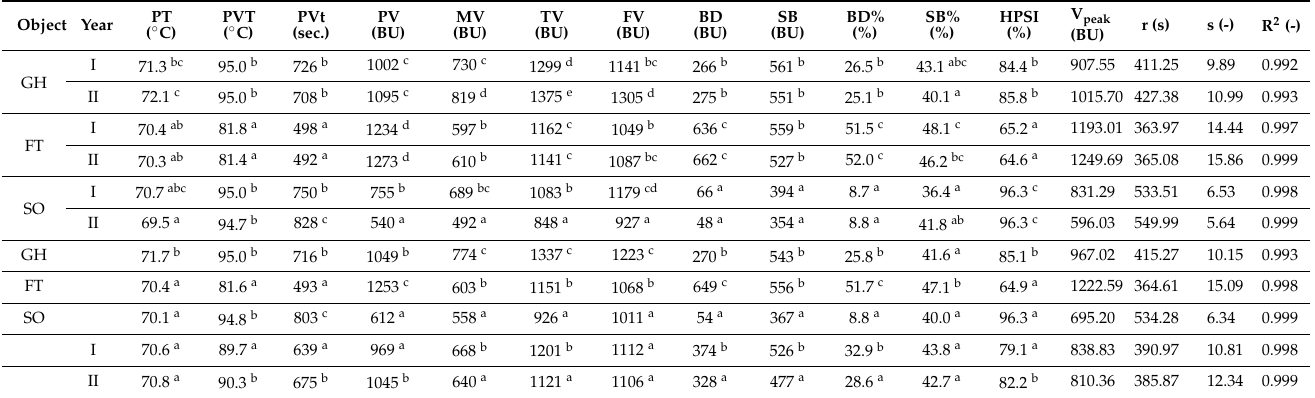
Table 4. Pasting characteristics of the investigated potato